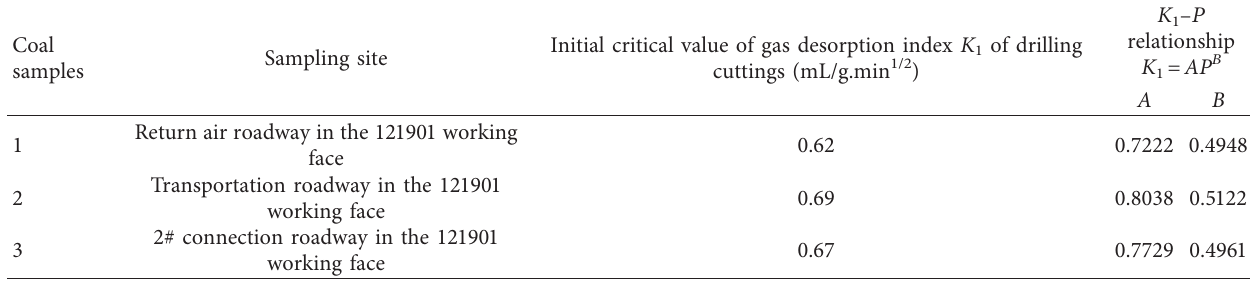
1 of drilling cuttings.